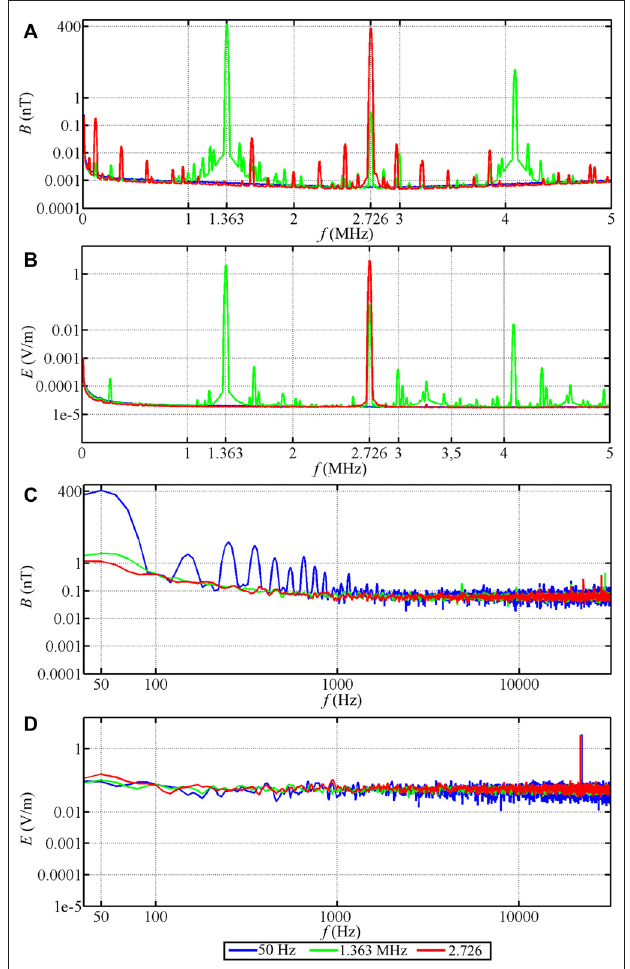
FIGURE 4 | Magnetic and electric field measurements of test conditions in spring 2013 . Traces in (A–D) show, respectively, the magnetic ( B ) and electric ( E ) component of the narrow-band electromagnetic fields in the range from 10 kHz to 5 MHz (A,B) and in the range from 40 Hz to 32 kHz (C,D) . The peak intensity in each condition was ∼ 400